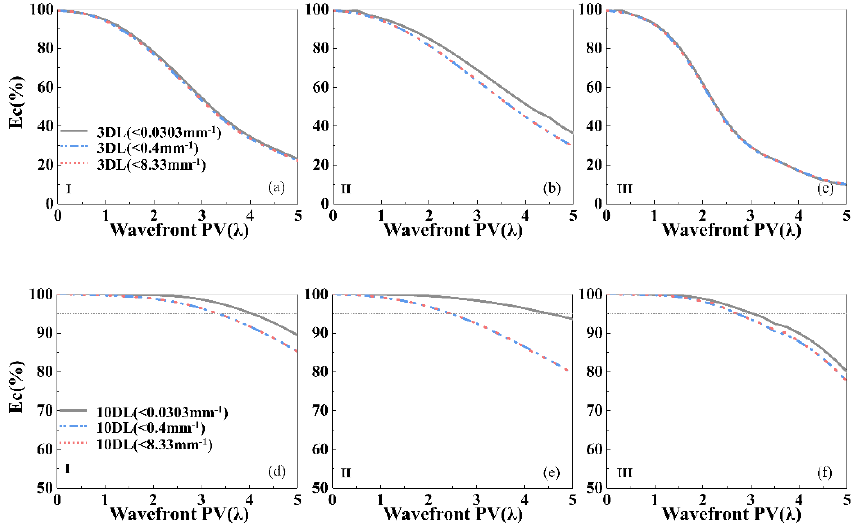
Figure 7. Ec 3DL / Ec 10DL variations in each spatial-frequency type with the original wavefront PV value. ( a – c ) are the changes in wavefront I, II, and III on Ec 3DL , respectively; ( d – f ) are the changes of wavefront I, II, and III on Ec 10DL , respectively.